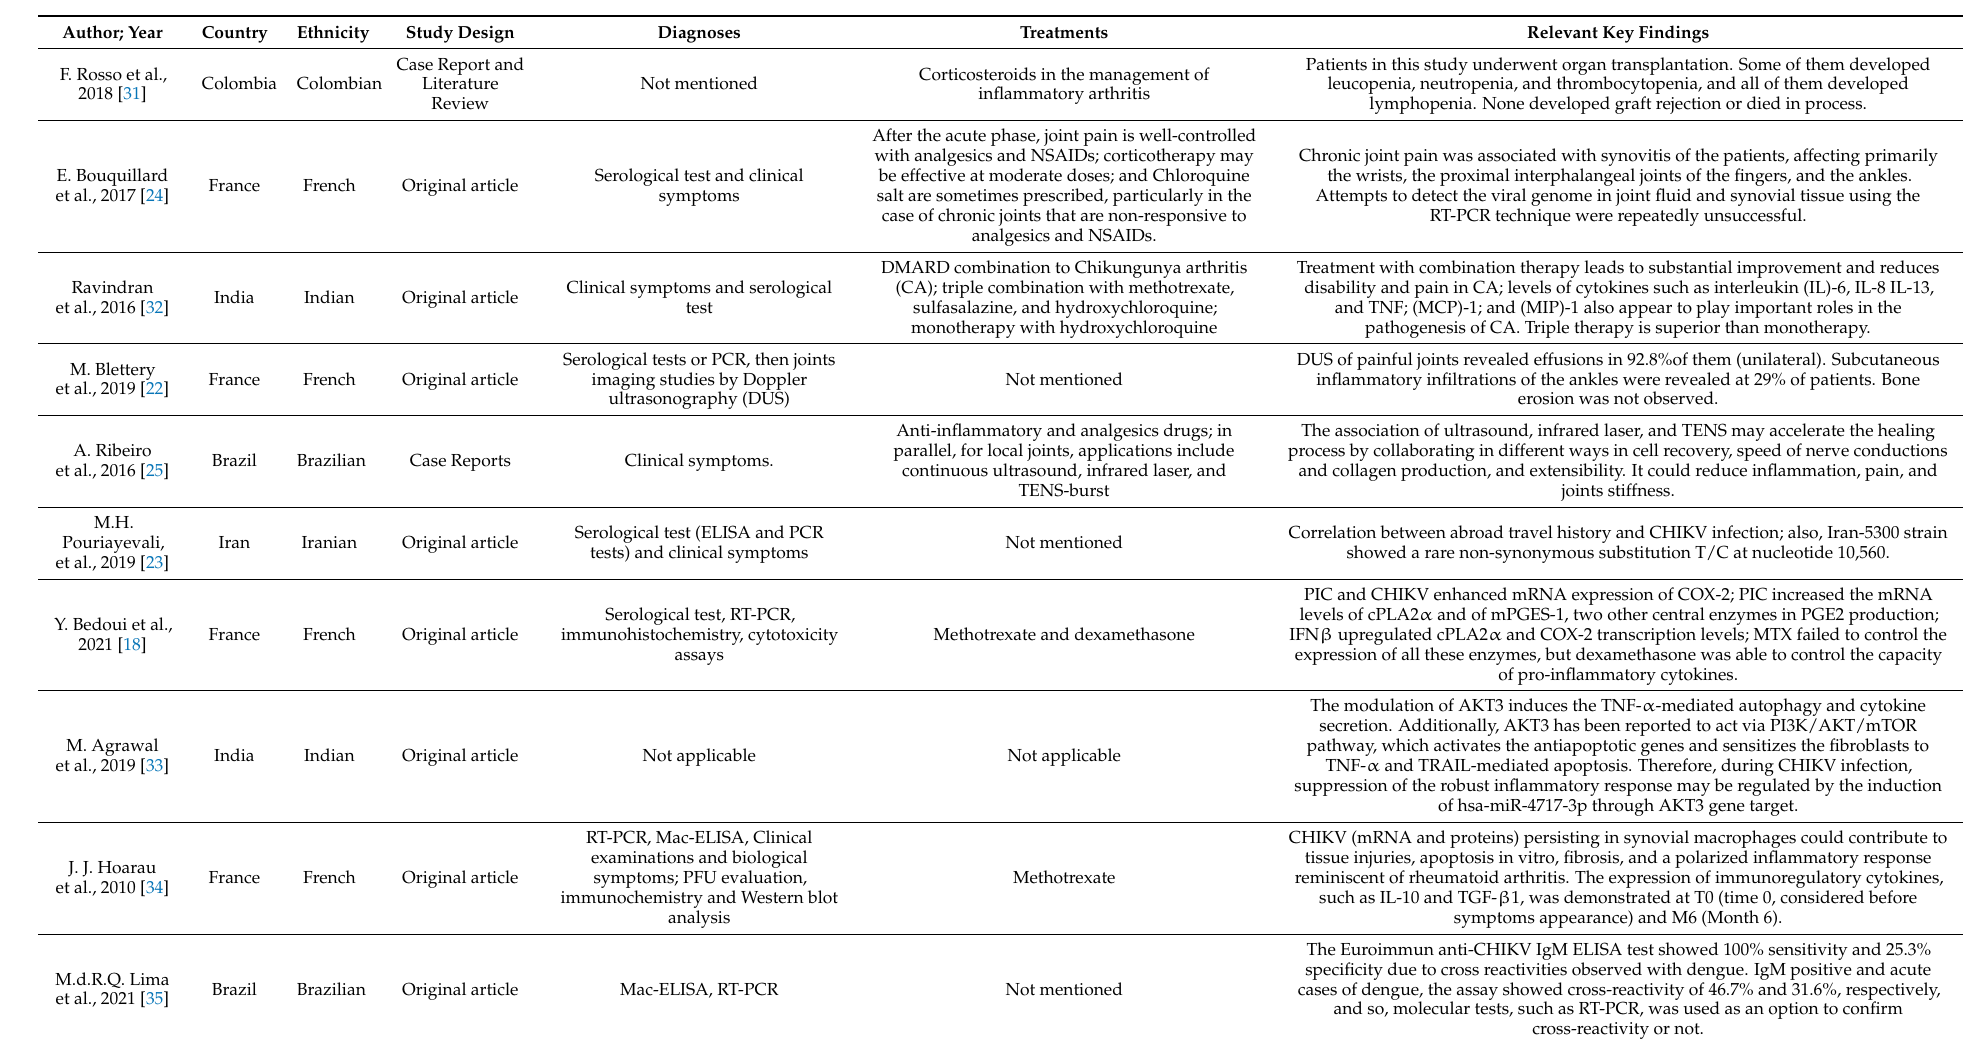
Table 1. Characteristics of observational studies evaluating the association between arthritogenic pain and CHIKV